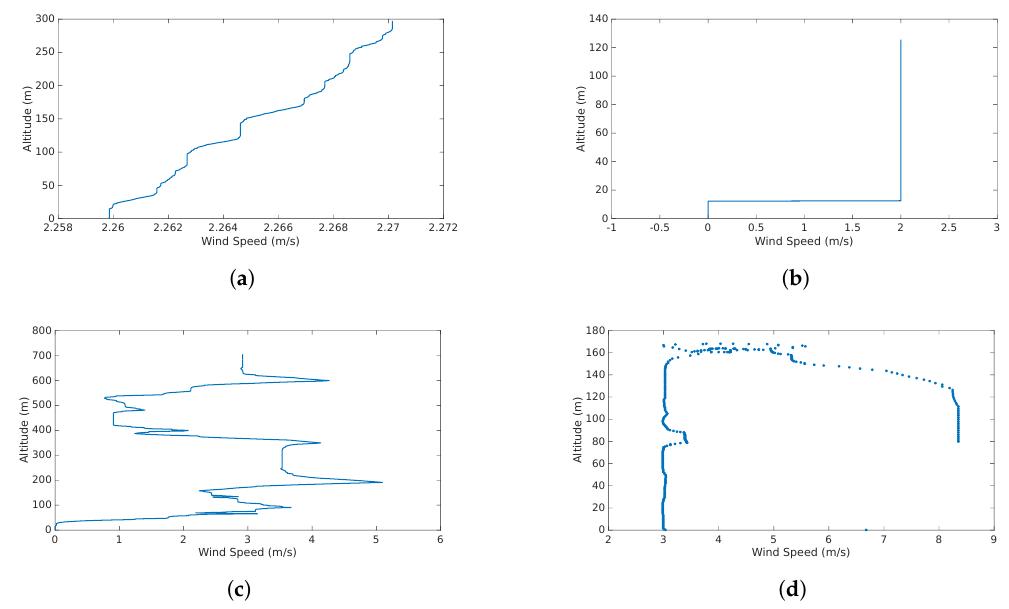
Figure 10. Wind Speed/Altitude maps of the different simulation scenarios: ( a ) the wind shear as an increase of wind speed with altitude; ( b ) a sudden increase in wind speed at a certain altitude (discrete gust); ( c ) a continuous gust with a chaotic effect and rapid increases and decreases of wind speed; and ( d ) the sum of the three effects.